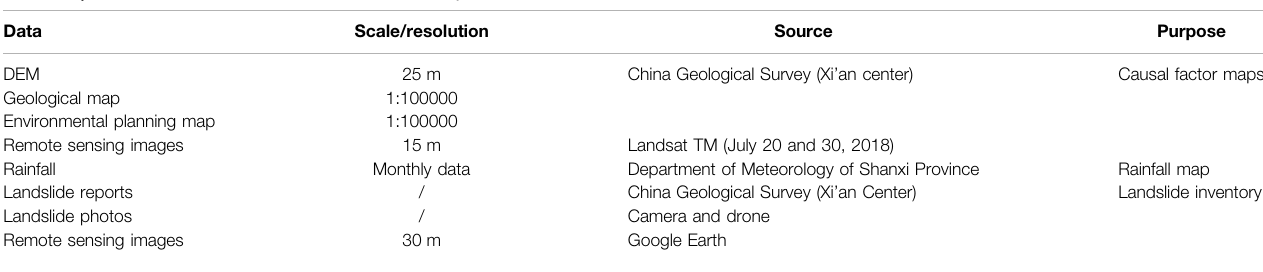
TABLE 1 | Detailed data and their sources used in this